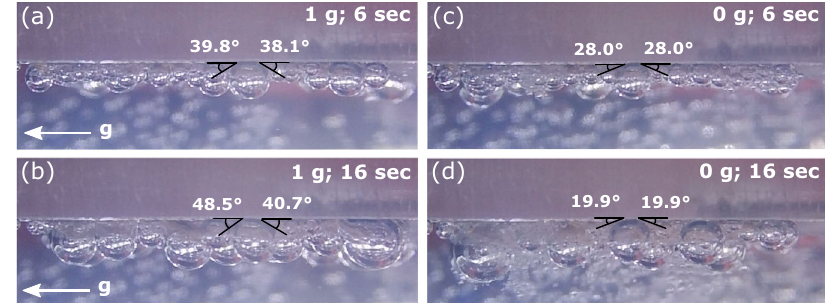
Fig. 6 Bubble contact angle analysis at 0 and 1 g. A comparison of bubble attachment angle at 1 g after 6 ( a ) and 16 ( b ) seconds of electrolysis, and at micro-g after 6 ( c ) and 16 ( d ) seconds of electrolysis. Contact angles were measured using imageJ; angles shown are a graphical representation. Average values are shown for each angle and tabulated in Supplementary Table 1.